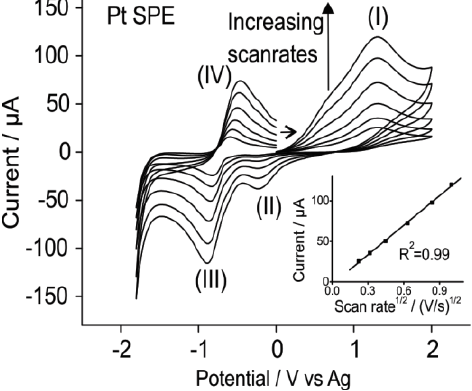
Figure 2. CV for the oxidation of 0.15% methylamine gas on a Pt SPE in [C 2 mim][NTf 2 ] at varying scan rates between 0.05 and 1 V/s. The inset shows the plot of peak current vs. the square root of scan rate for peak